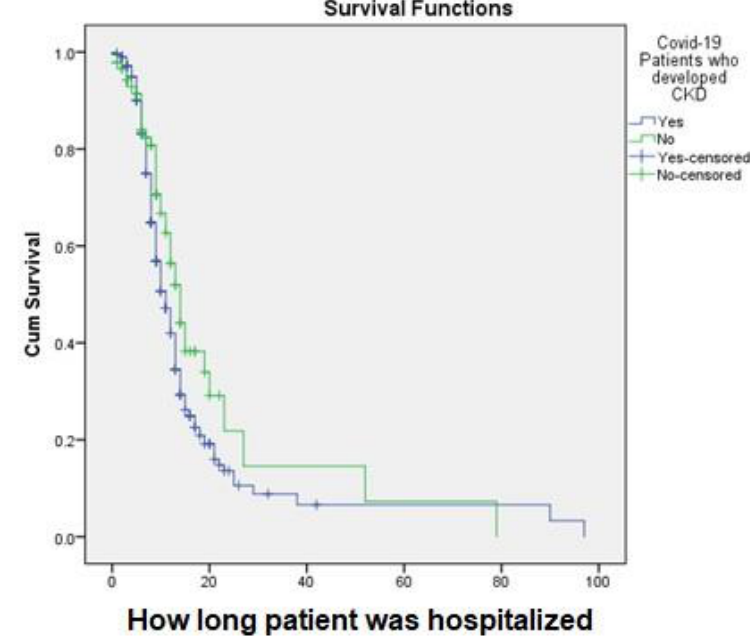
Figure 3. Kaplan–Meier survival analysis of the type of Figure 3. Kaplan – Meier survival analysis of the type of CKD.